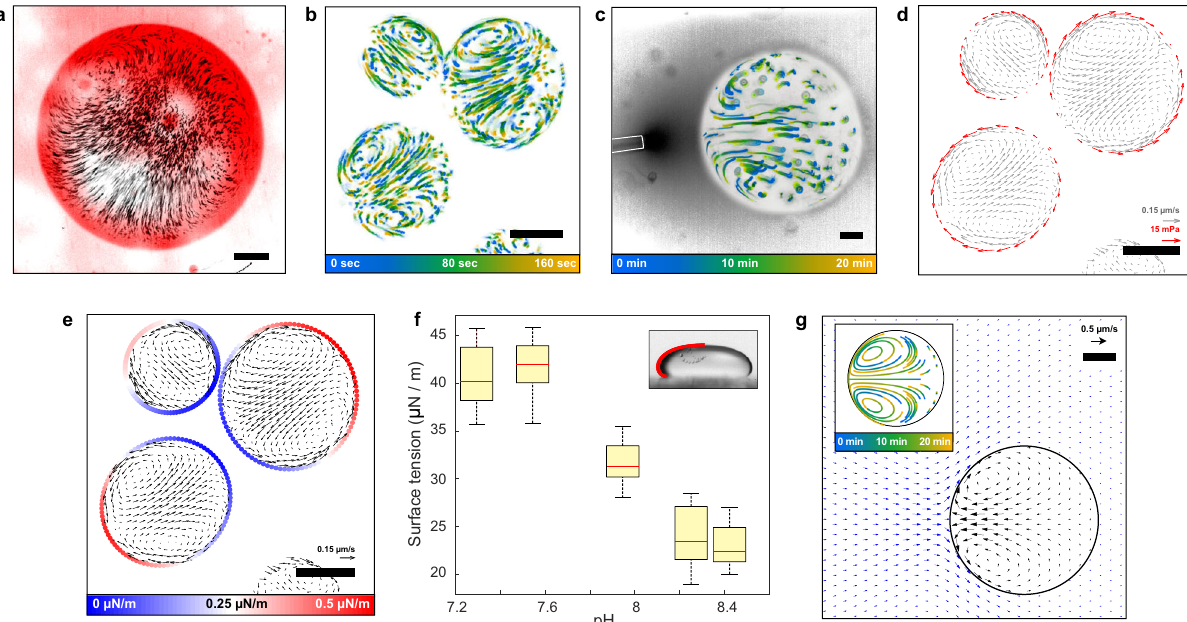
Fig. 3 Activity-induced fl ow. a Fluorescent intensity of rhodamine diffusing in an active droplet (1 μ M urease in the droplet, 100 mM urea) after 200 s from addition (red), overlapped on the time projections of fl uorescent tracers (black). b Time projection of fl uorescent intensity for a group of three active droplets (1 μ M urease in the droplet, 100 mM urea). The tracks show the color-coded trajectories of fl uorescent tracers. c Time projection of fl uorescent intensity for a droplet and micropipette. The tracks show the color-coded trajectories of fl uorescent tracers, while the dark halo the released solution. d Shear stress vectors calculated at the droplets' edges (red arrows) overlapped on the fl uid velocity fi eld (gray arrows) for the droplets in panel b . e Delta surface tension integrated along the droplets' edges overlapped on the fl uid velocity fi eld (black arrows) for the droplets in panel b . f Box plot of surface tension difference between the supernatant and droplet phase as a function of the pH of the supernatant, calculated with the sessile drop method 50 (inset). The central mark indicates the median, the top and bottom edges of the box the 25th and 75th percentile, the whiskers the maximum and minimum value of the data. For each point, 20 individual droplets were analyzed ( n = 20). The droplet in the inset has a radius, at its widest point, of 600 μ m. g The induced fl ow fi eld inside (black arrows) and outside (blue arrows) of the droplet in the micropipette experiment, obtained from the theoretical model (see SI for details). Time projection of the fl ow trajectory inside the droplet is shown in the inset. All the scale bars are 20 μ